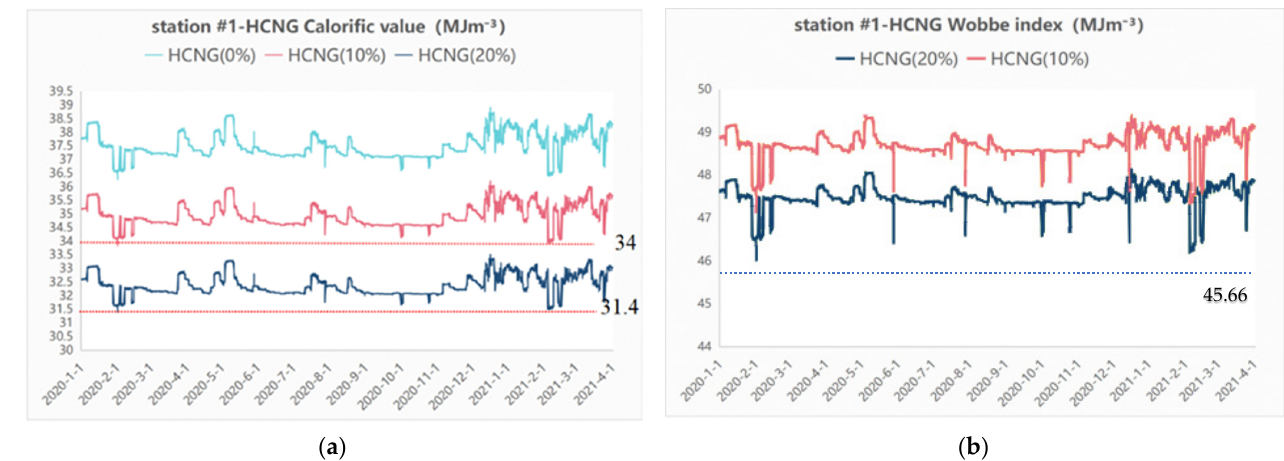
Figure 3. ( a ) Calorific value of natural gas source station #1 measured between 2020.1 and 2020.4 . ( b ) Wobbe Index of natural gas source station #1 measured between 2020.1 and 2020.4.